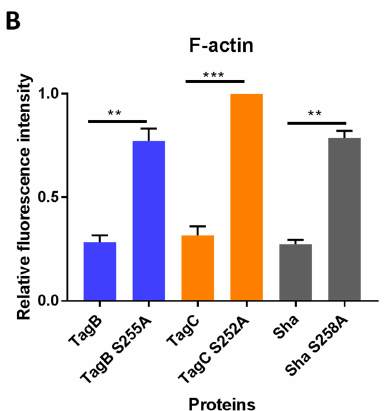
Figure 5. Intracellular localization of TagB, TagC, and Sha determined by confocal microscopy. ( A ) Z-stack imaging showing the localization of TagB, TagC, and Sha and their respective serine active site mutant variants during interaction with 5637 bladder epithelial cells after 5 h of incubation. SPATEs were detected by Alexa Fluor 594 (white arrowheads, red fluorescence) using anti-mouse secondary antibody and actin was stained by Alexa Fluor 488- phalloidin (green fluorescence). Images are displayed in a 3D section view with large Z-sections in the X-Y direction (R), Z-projection in the X–Z direction (P), and Z-projection in the Y–Z direction (Q). The green and red lines in R indicate the orthogonal planes of the X–Z and Y–Z projection. For each selected section, the signal was gathered from a span of 5 µm. Scale bar: 10 µm ( B ) Quantitative analysis of fluorescence intensity of F-actin in the cells treated with native or mutant SPATEs. Analysis of fluorescence intensity was done in green channel by measuring the mean gray value on ImageJ. Data represent the mean ± SEM of at least three independent experiments. Significant differences between fluorescence intensity of each native and mutant SPATE treated cell was determined using Student’s t-test with ** p < 0.01, *** p < 0.001. Analysis of thin-sections of SPATE-treated cells using immunogold staining and transmission electron microscopy (TEM) also confirmed the intracellular localization of all three SPATEs within cells. TagB and Sha were found in the cytoplasm, whereas TagC was present in the nucleus (Figure 6). However, in multiple independent experiments, we failed to detect the presence of serine mutant variants of TagB, TagC, or Sha within cells. The serine catalytic-site mutant proteins when visualized were almost exclusively observed on the extracellular surface of cells as seen in cells treated with TagB S255A (Figure 6D).